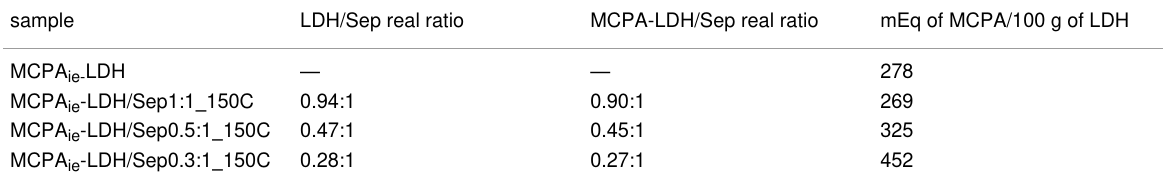
Table 1: Amounts of MCPA in mEq/100 g of the hybrid and materials prepared by the ion exchange method. sample LDH/Sep real ratio MCPA-LDH/Sep real ratio mEq of MCPA/100 g of LDH MCPA ie-